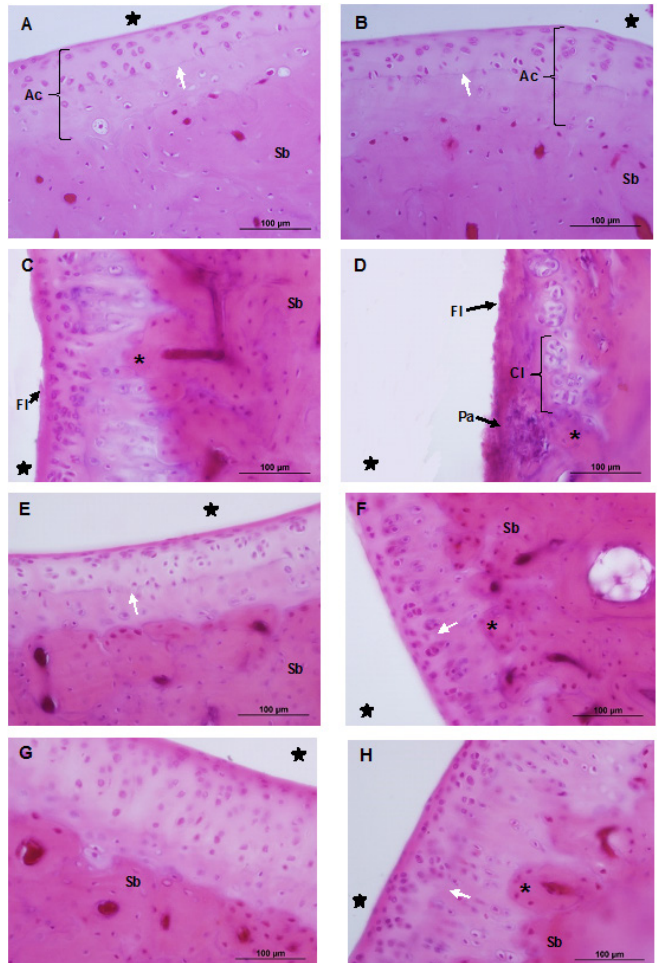
Fig. 1: Photomicrographs of the ankle joint of Wistar rats, showing the articular cartilage. Sagittal section, hematoxylin and eosin staining. A, C, E and G - cartilage of the tibia; B, D, F and H - cartilage of the talus. Control group (A and B), Lesion group (C and D), Exercise group (E and F), and Lesion and Exercise group (G and H). In A and B, showing the articular cartilage (Ac) and the presence of tidemark (white arrow) with normal appearance. In C, the presence of flocculation (Fl) on the surface of the cartilage and invagination of the subchondral bone (asterisk). In D, forma - tion of pannus (Pa) and the presence of cell clones (Cl) and flocculation (Fl) is more evident. In E and F, slight discontinuity of tidemark (white arrow) and in F, moderate invagination of the subchondral bone (asterisk). In G, the absence of tidemark. In H, invagination of the subchondral bone (asterisk) and reorganization of articular cartilage including tidemark (white arrow). Articular cavity (star) and subchondral bone